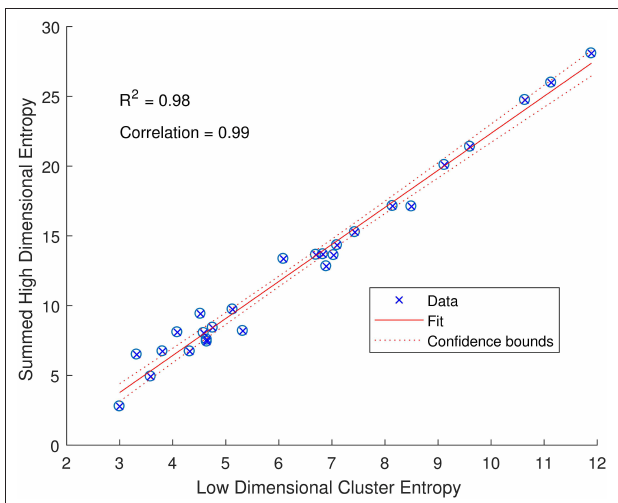
FIGURE 5 | Relationship between the entropy of low dimensional clusters in Figure 3A and the entropies of the high dimensional CMR data (summed over all attributes). The data (blue crossed circles) have a high Pearson’s correlation of 0.99 and follow a linear fit (solid red line) with an R 2 of 0.98 and a narrow 95% confidence bound (dashed red line) as indicated.